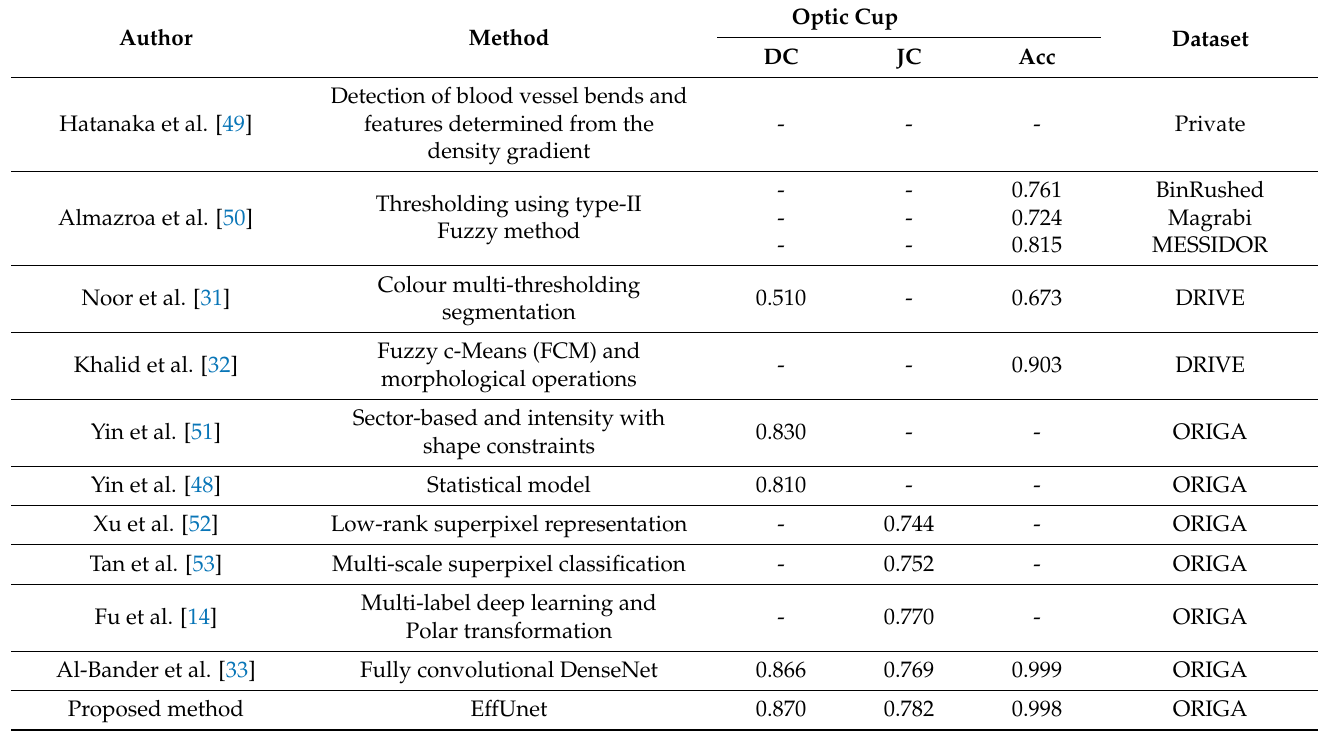
Table 3. Comparison of segmentation methods for optic cup.